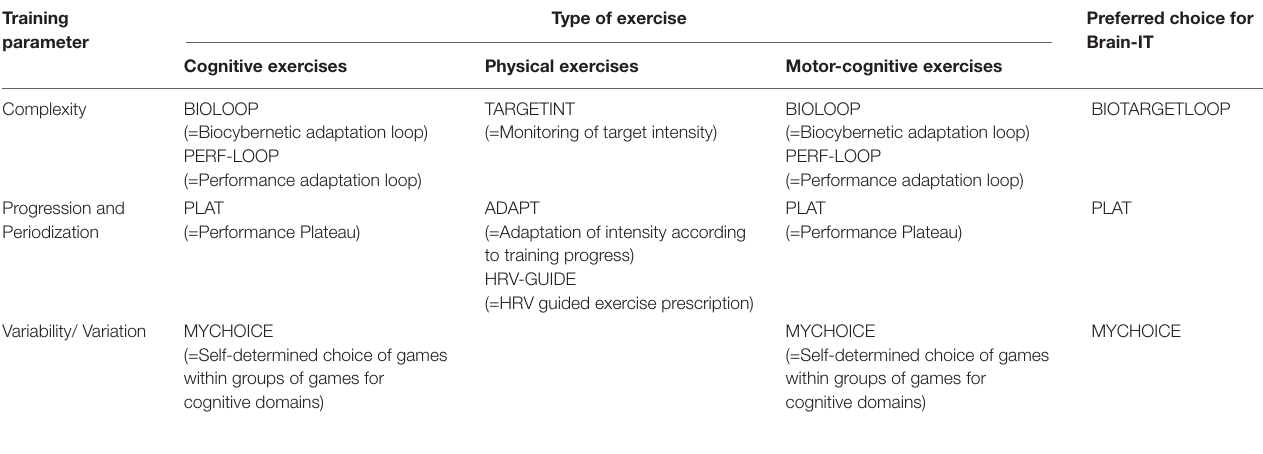
TABLE 4 | Possible ideas/concepts for training